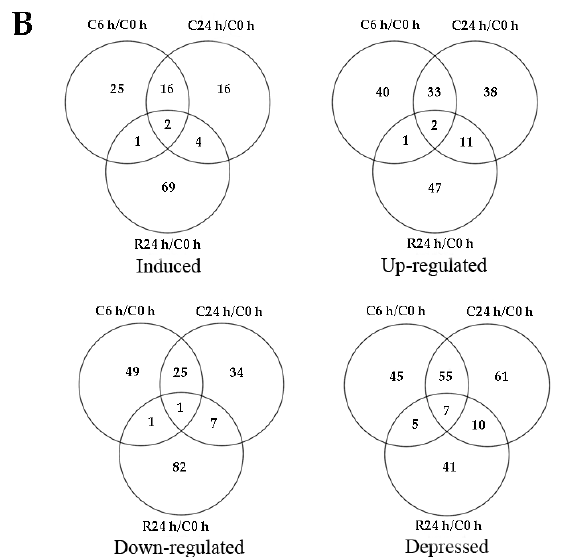
Figure 3. Statistical analysis of phosphoproteomics of J. curcas seedling under different treatment. The significantly changed phosphopeptides in each sample (C6 h, C24 h and R24 h) when compared to C0 h ( A ); Venn diagram of significantly changed phosphorylation sites and phosphoproteins distributed in each sample (C6 h, C24 h and R24 h) when compared to C0 h ( B ).